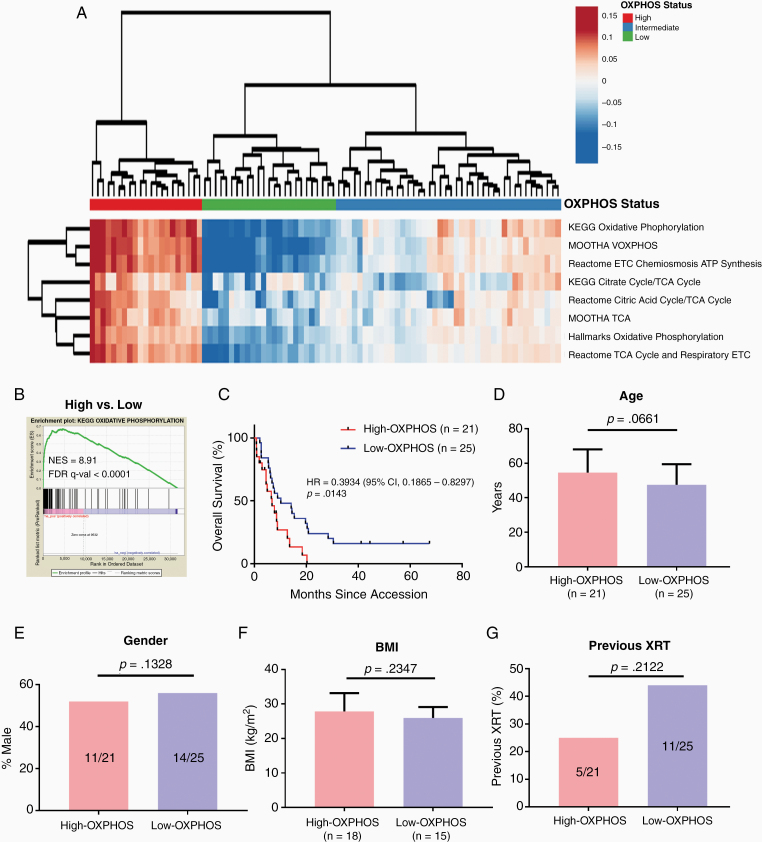
Identification of High-OXPHOS and Low-OXPHOS melanoma brain metastases. (A) Hierarchical clustering of the OXPHOS-Indices from 88 melanoma brain metastases (MBMs) with available RNA-seq data resulted in the formation of 3 clusters: MBMs with significant enrichment (High-OXPHOS; n = 21); depletion (Low-OXPHOS; n = 25); or intermediate (Intermediate-OXPHOS; n = 42) OXPHOS gene set enrichment. Results are represented as a heatmap of median-centered values from each of the 8 components of the OXPHOS-Index. (B) GSEA-P confirming enrichment of OXPHOS in MBMs identified as High-OXPHOS versus Low-OXPHOS. (C) Kaplan–Meier analysis of overall survival from craniotomy for patients with High-OXPHOS versus patients with Low-OXPHOS MBMs. Hazard ratio determined via Mantel-Haenszel test and significance by log-rank test. (D–G) Comparison of clinical variables between patients with High- and Low-OXPHOS MBMs, including mean age, gender, mean body mass index (BMI), and frequency of previous radiation XRT). Significance was determined for age and BMI via 2-sided Student’s t-test; gender and frequency of prior XRT were compared via 2-sided Fisher’s exact test.